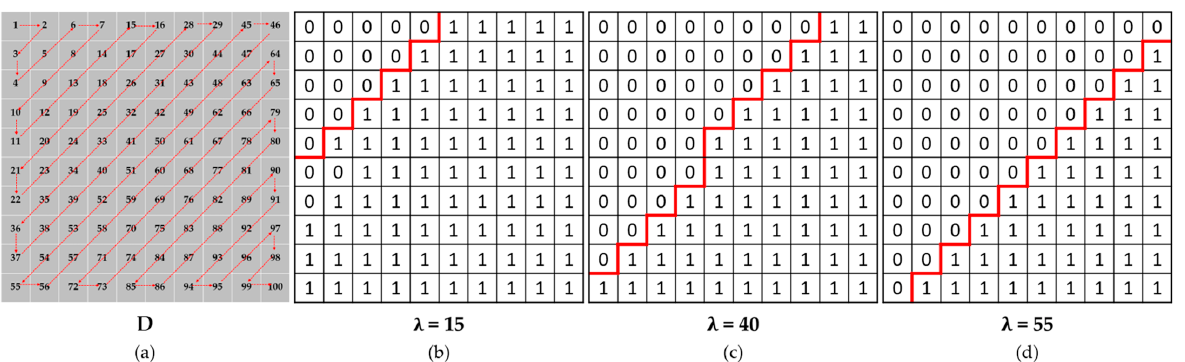
Figure 8. Configuration of RCAB [6] structure.